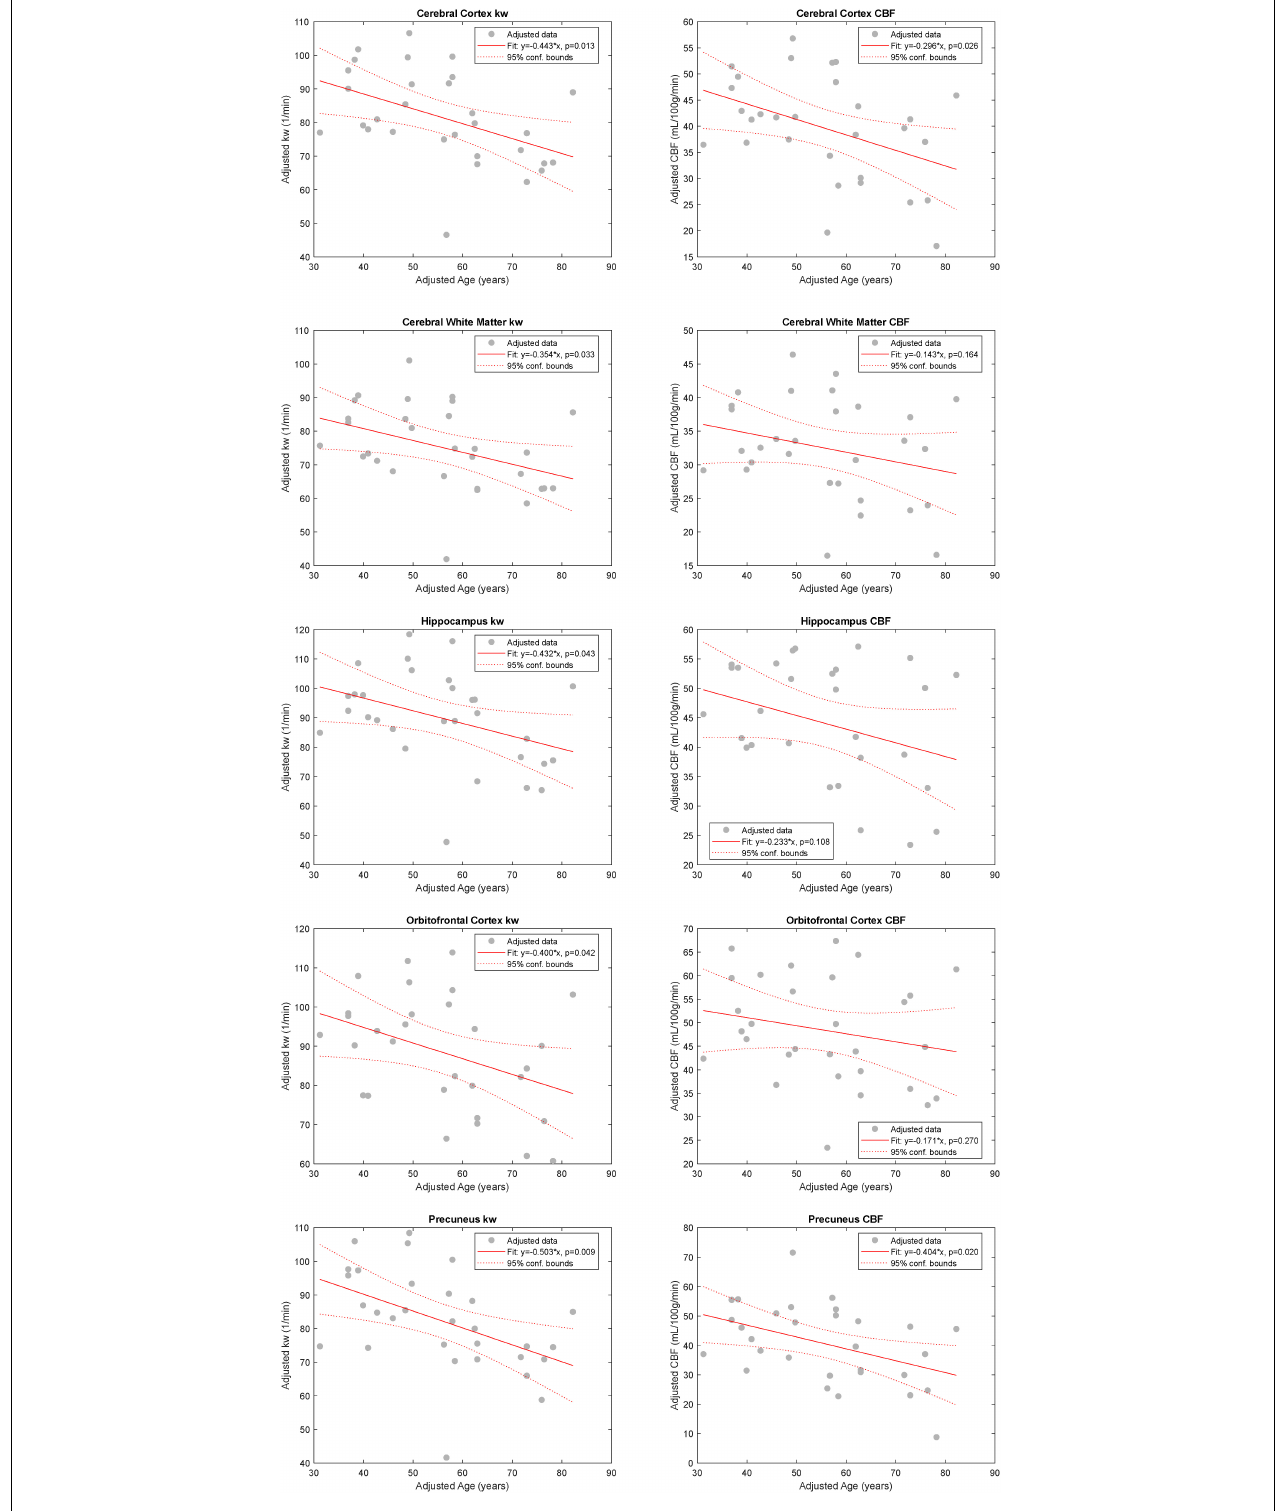
FIGURE 2 | Relationship between k W and CBF with Age. Added variable plots obtained by multiple linear regression analysis showing the relationship between k W and CBF with age ( n = 30), adjusting for sex and the number of vascular risk factors. There was a statistically significant association between age and k W in all five evaluated regions: cerebral cortex (CTX), cerebral white matter (CWM), orbitofrontal cortices (OFC), and precunei cortices (PCN). With respect to CBF, age was found to be statistically significant only in CTX and PCN.